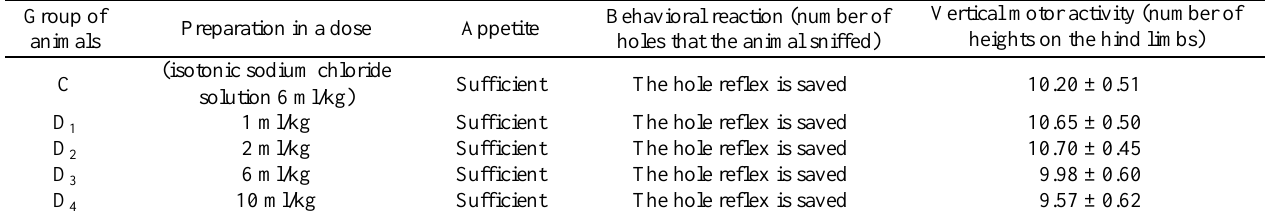
Indicators of the physiological state and activity of laboratory rats for 21 daily introduction of the ferrocellus T (M ± m; n = 10) Group of